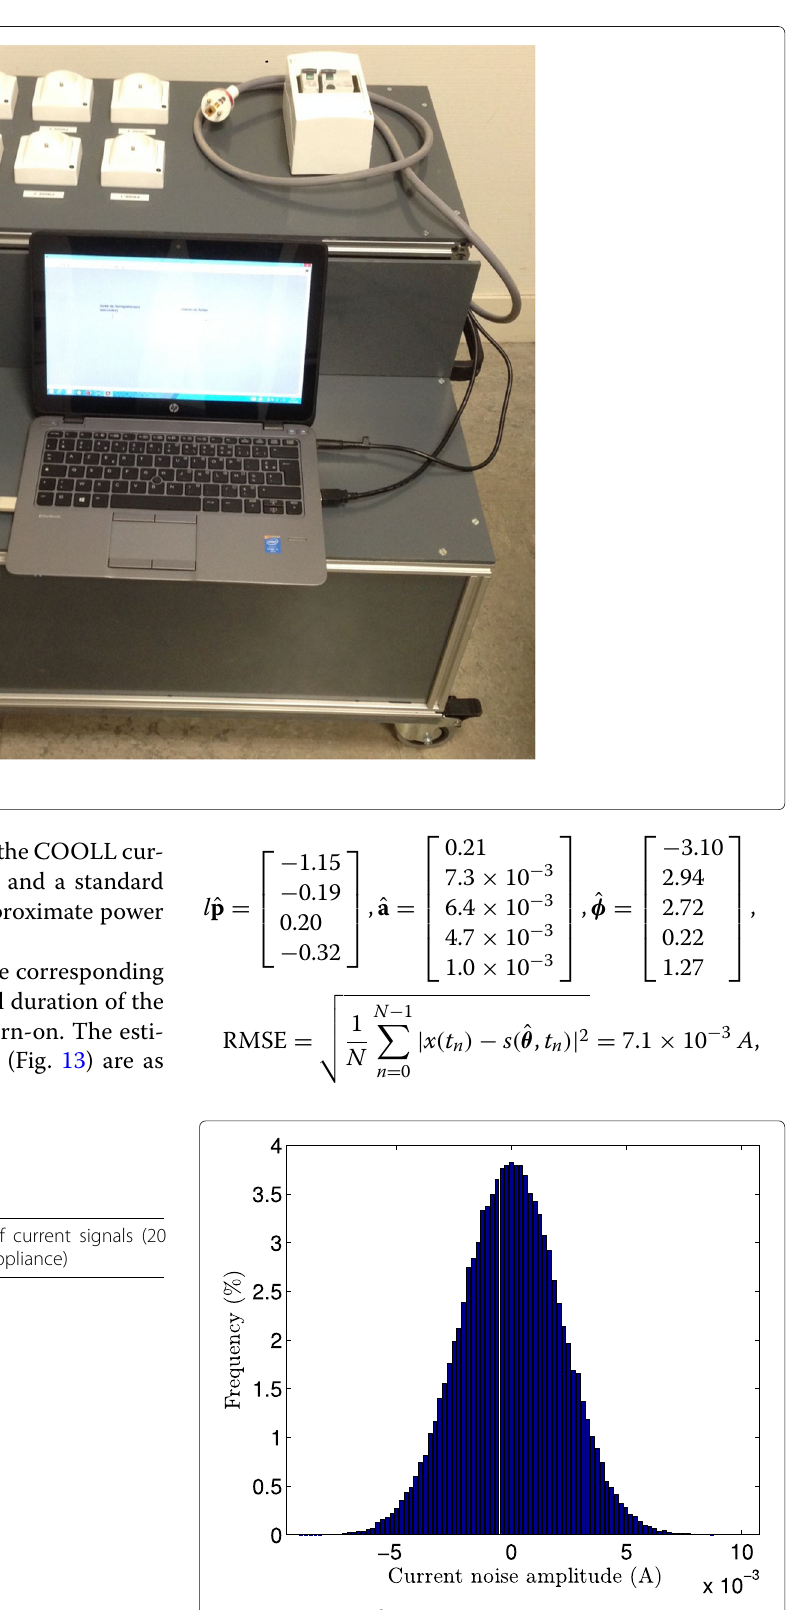
Fig. 12 Histogram of current